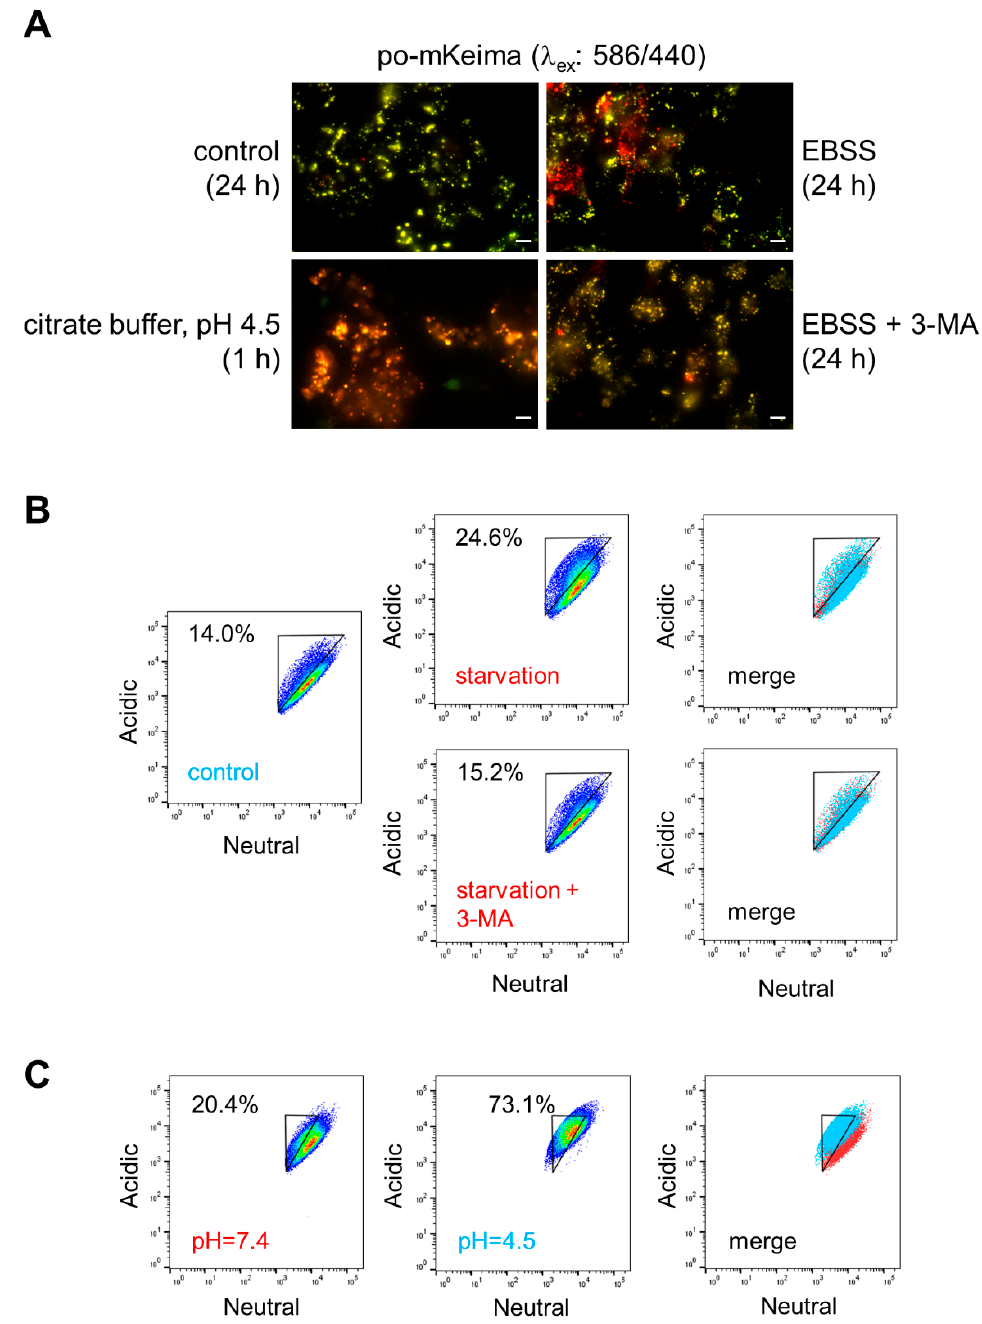
Figure 2. In situ detection of starvation-induced pexophagy. DD-DAO Flp-In T-REx 293 cells stably expressing po-mKeima were precultured for two days in rMEM α . At time zero, the medium was replaced with pre-warmed rMEM α (control), Earle’s balanced salt solution (EBSS) supplemented or not with 5 mM 3-methyladenine (3-MA), or a citrate buffer (pH 4.5). After the indicated times, the cells were processed for fluorescence microscopy or FACS analysis. ( A ) Representative images of the po-mKeima staining patterns in each group. Images were captured as described in the Materials and Methods section. Scale bar, 10 µm. ( B,C ) Representative flow cytometry plots of each group. Note that a decrease or increase in the fluorescence intensities of the neutral and acidic channels can be used to gate and quantify the percentage of cells undergoing pexophagy (starvation) and acidification of the peroxisome lumen (citrate buffer, pH 4.5), respectively. The different colors represent the cell density at a given position.